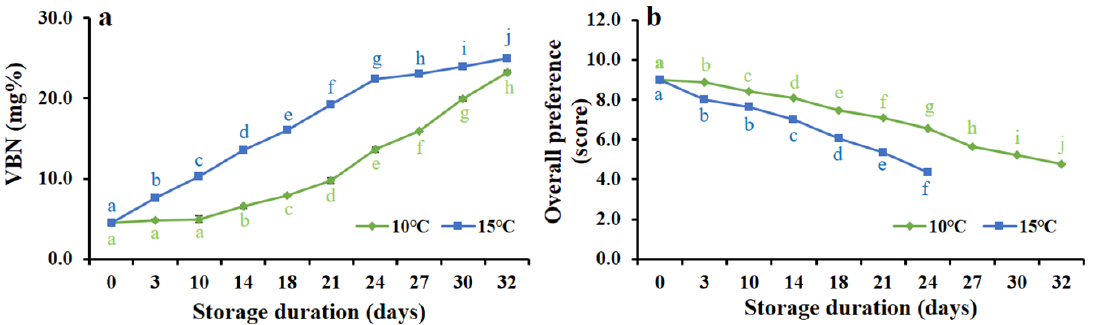
Figure 5. Consequences of storage time on ( a ) volatile basic nitrogen (VBN) and ( b ) sensory evaluation (overall preference) of hot smoked HDPS at two different storage temperature of 10 °C and 15 °C Data represent the mean ± std of 10 observations, where groups not sharing a letter is expressed as significantly different ( p < 0.05).